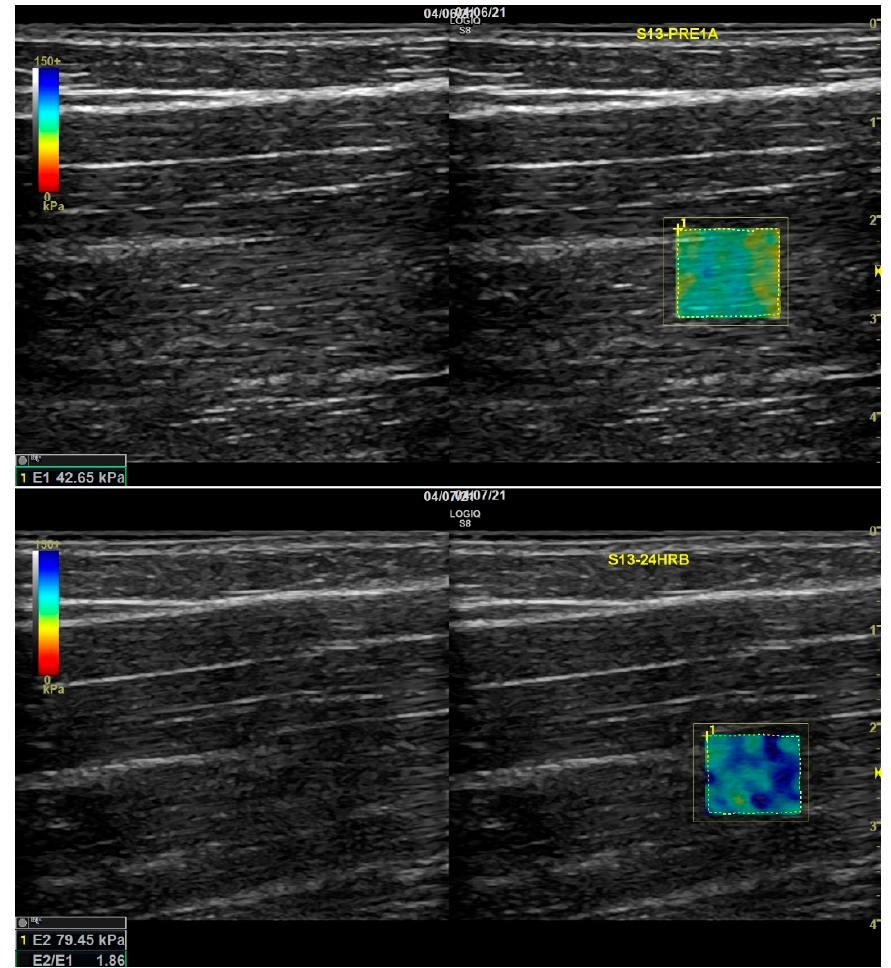
Figure 1. Example of shear wave elastography measurement at Pre (top = 42.65 kPa) and 24 h (below = 79.45 kPa) in an eccentric damage participant.